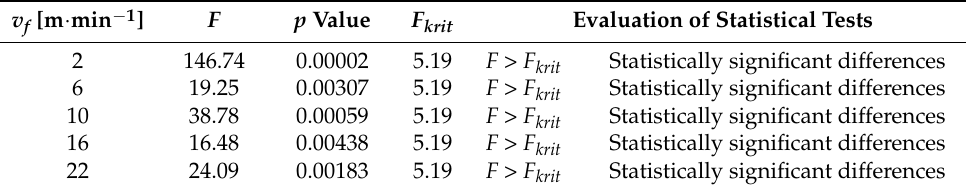
Table 3. ANOVA analysis: influence of temperature on the cutting force per single